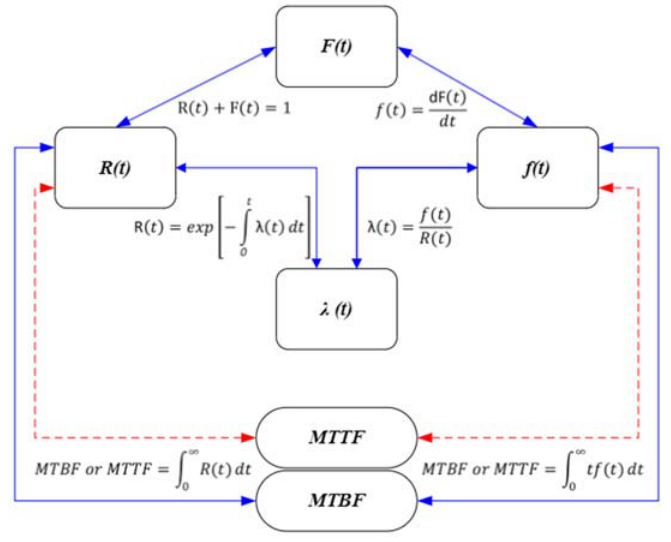
Figure 2. Reliability function correlation diagram.